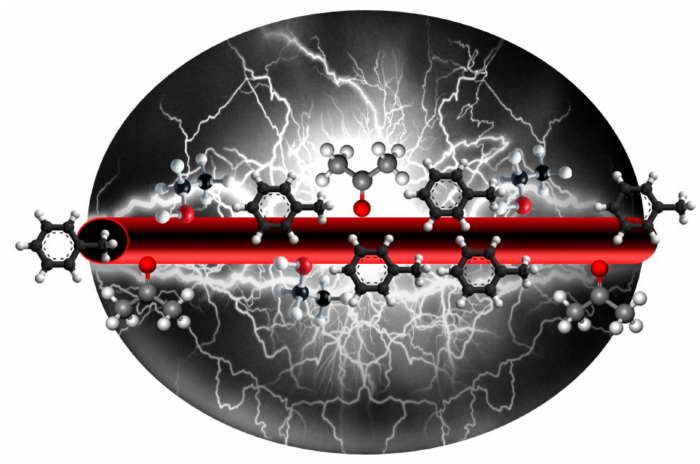
Figure 1. Electrically conductive oxygenated amorphous carbon (a-CO x ) / graphite (G) (a-CO x / G) nanofibers able to sense polar (here, ethanol and acetone) and non-polar (here, toluene) volatile organic compounds